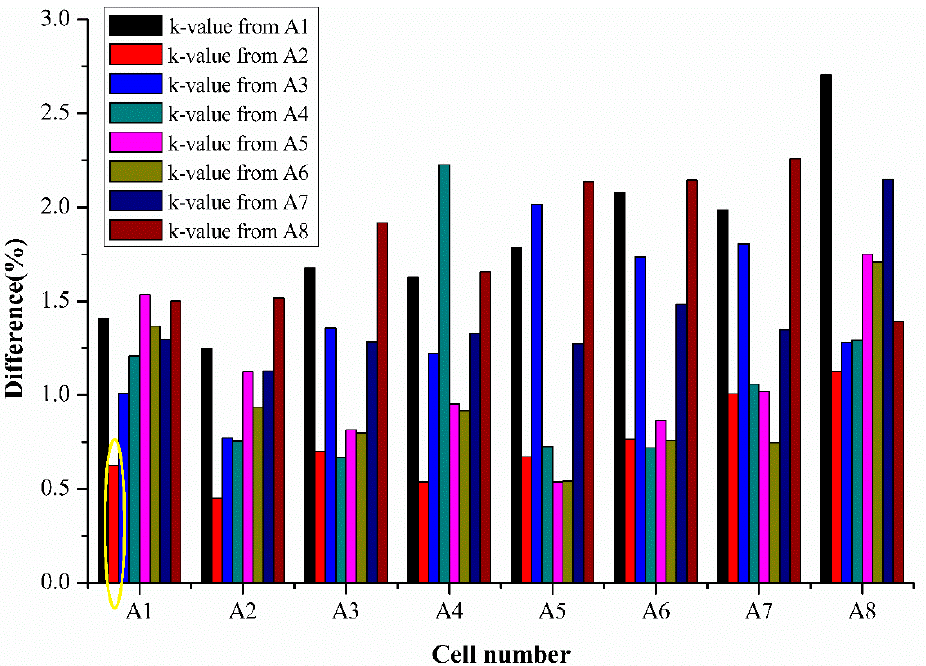
Figure 8. The Histogram of estimation of the mean difference calculated from each cell by their K-value. The “K-values from A1” means the (k1, k2, k3) obtained from the cell A1.